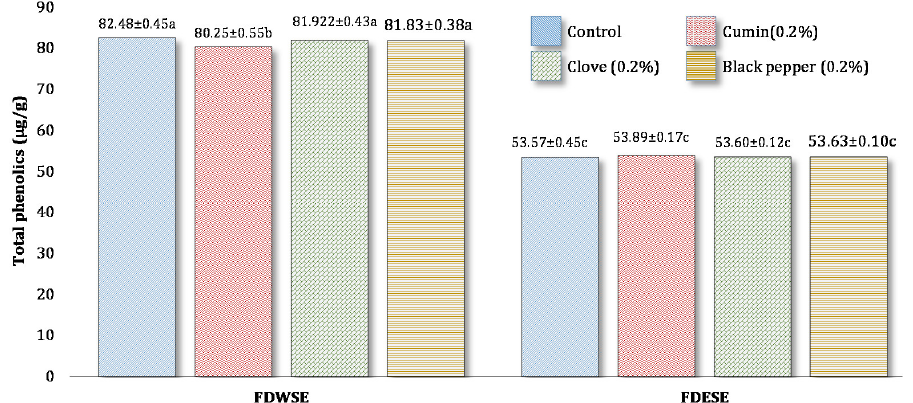
Figure 4. Mean values for Total phenolic content (TPC) (µg/g gallic acid equivalent) of freeze-dried water-soluble (WSE) and ethanol-soluble extract (ESE) of processed Cheddar cheese made from buffalo milk after ripening. a–c means followed by the same letter for each type of processed Cheddar cheese are not significantly different ( p <